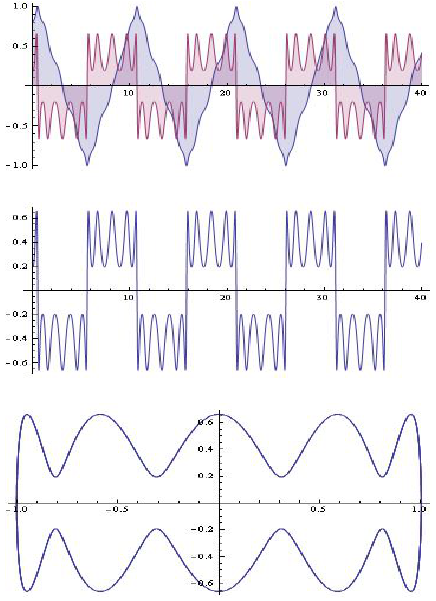
Figure 13. The solutions of the system (12) (Example